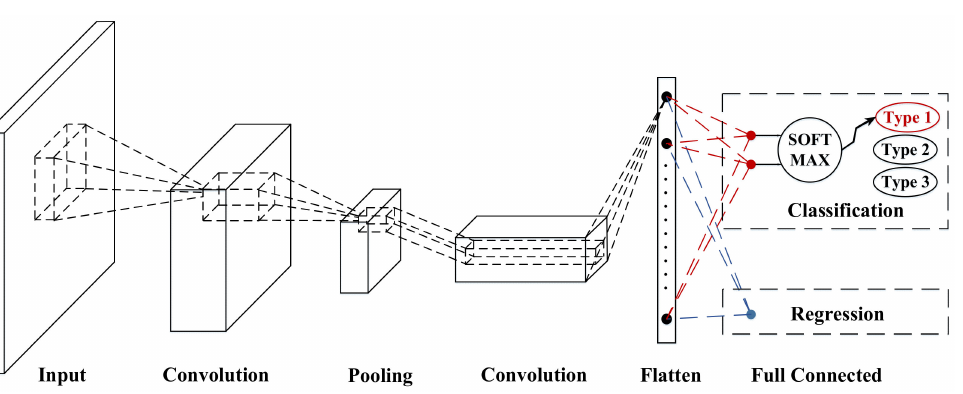
Figure 3. The illustration of a basic